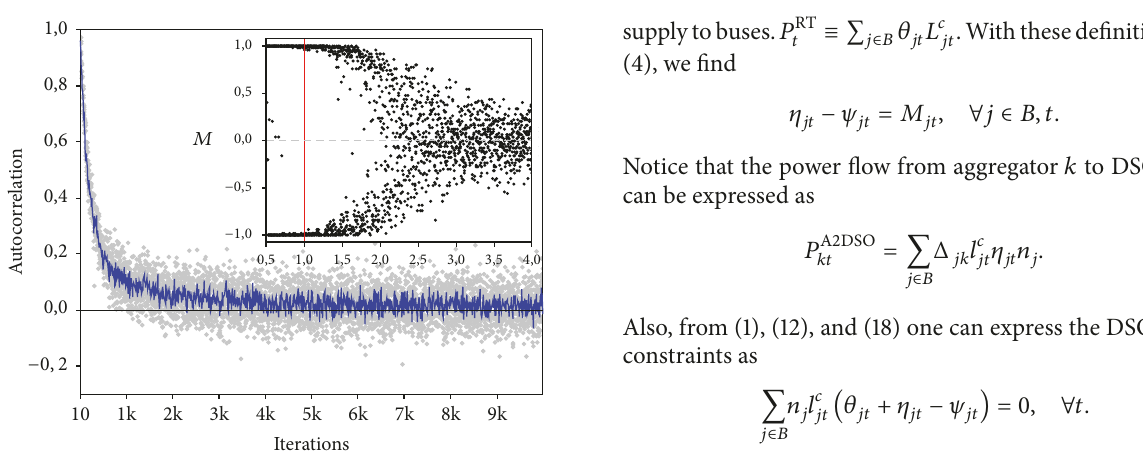
Figure 2: Autocorrelation function for the spin states between initial and evolved configurations. Grey dots represent numerical realisations and the blue line represents the average. The inset shows the phase transition in 𝑀 beyond 𝑇 𝑐 (red